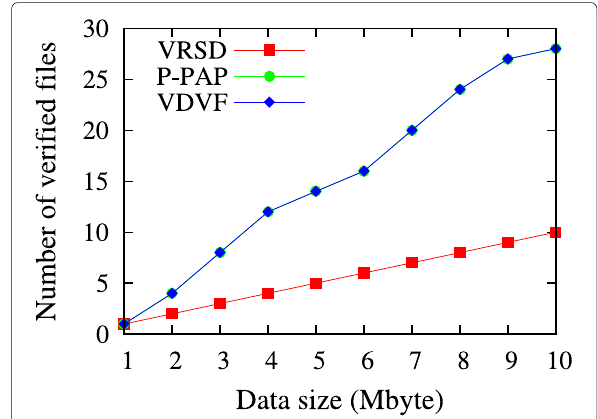
Fig. 10 Number of verified files under the same data verification quantity